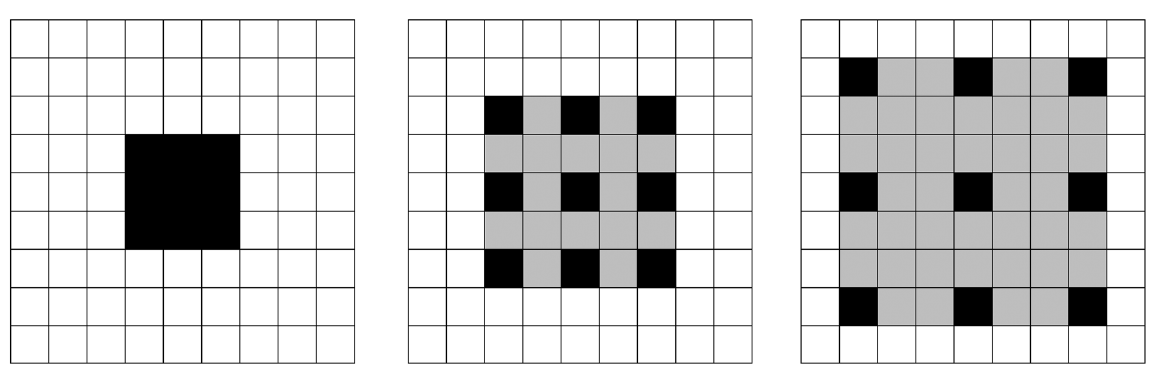
Figure 4. Comparison of receptive fields between regular convolution and dilated convolution. From left to right: (1) regular convolution, (2) dilated convolution ( r = 2), and (3) dilated convolution ( r =